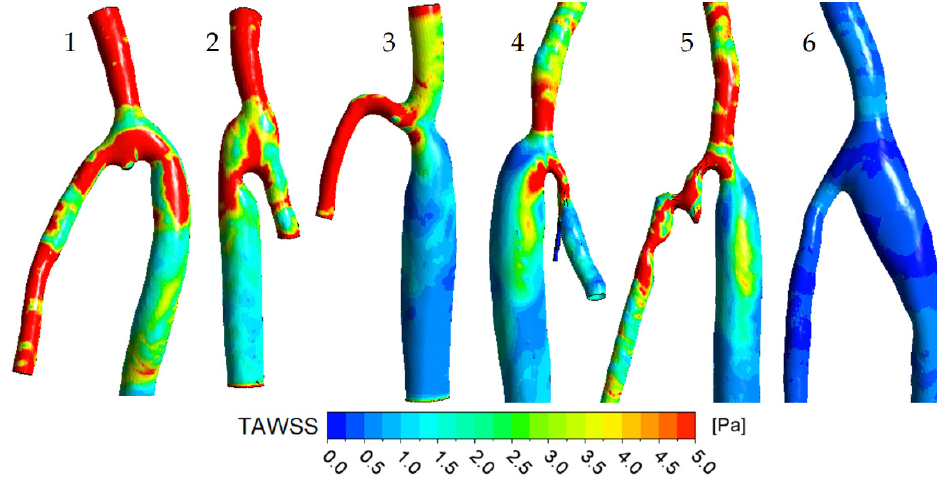
Figure 9. Time-average wall shear stress distributions.